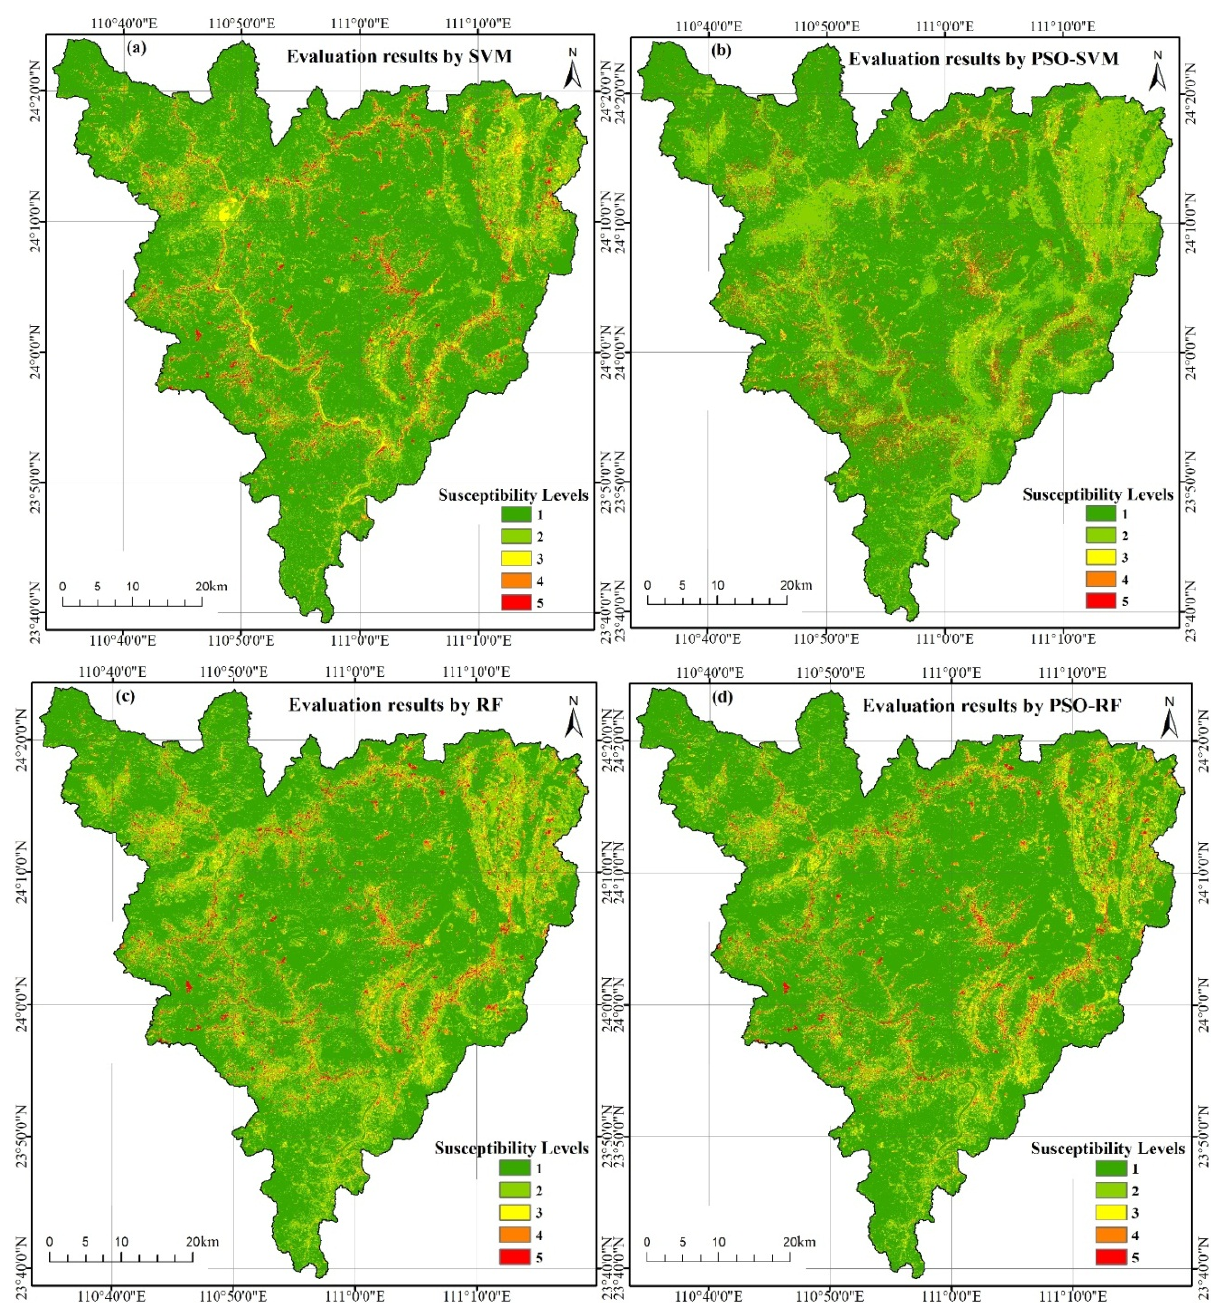
Figure 4. Evaluation results of landslide susceptibility for four ML models in Zhaoping (1-extremely low, 2-low, 3-medium, 4-high, 5-extremely high; ( a ) SVM; ( b ) PSO-SVM; ( c ) RF; ( d ) PSO-RF).